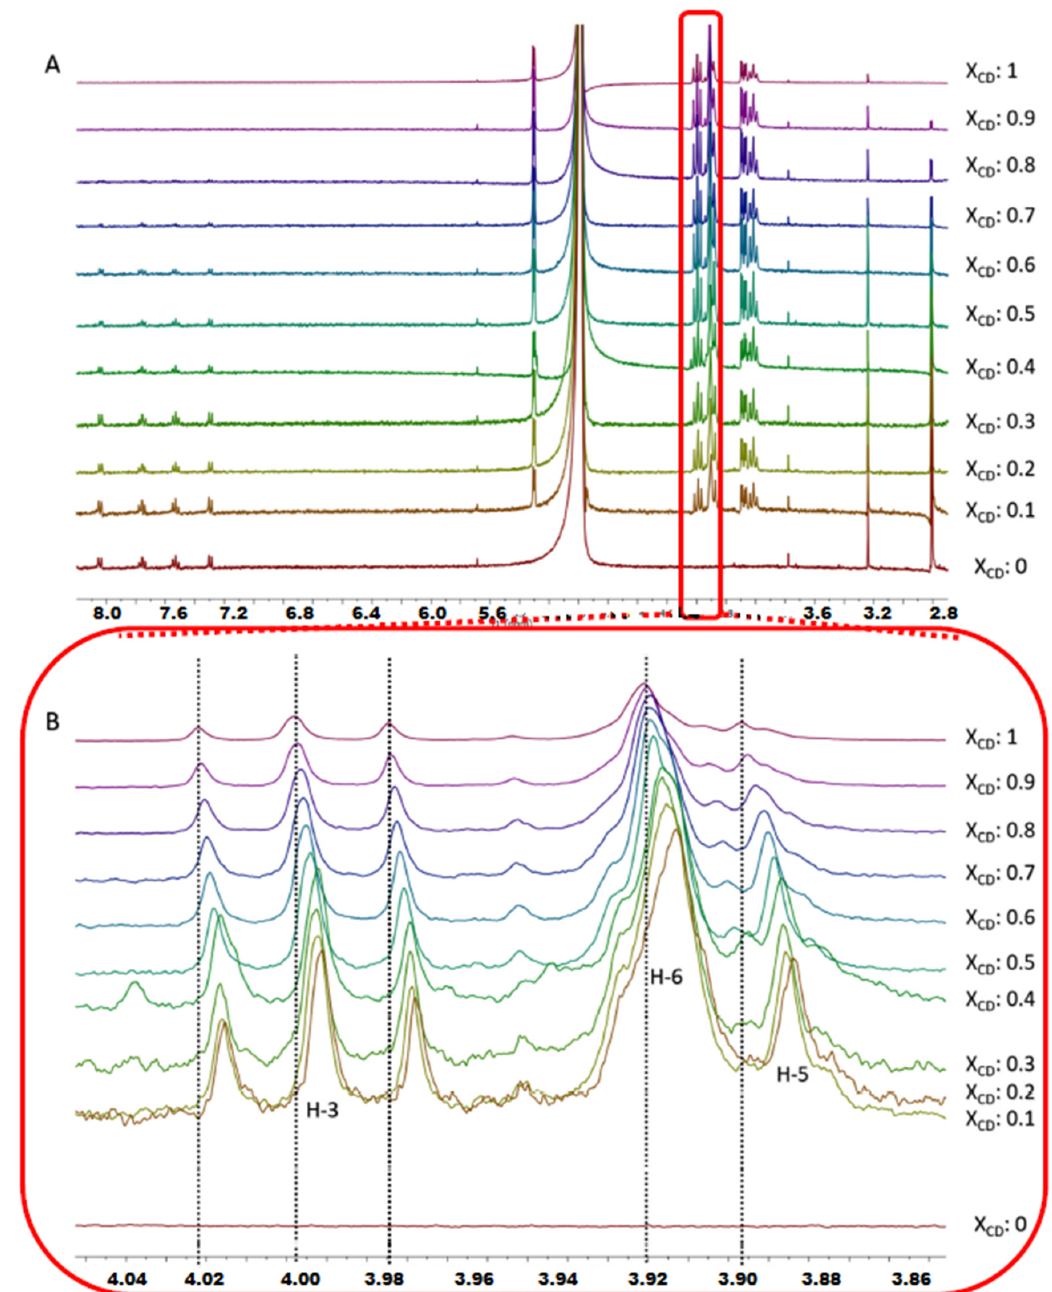
Figure 2. ( A ) 1 H-NMR spectra for different molar fractions of 1a : β -CD; ( B ) expansion of the region of H-3 , H-5 and H-6 protons of β -CD.